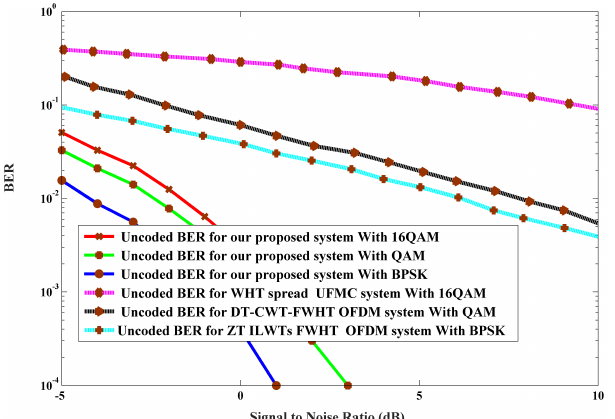
Figure 23. BER performance comparison between the proposed uncoded system with other multicar- rier uncoded